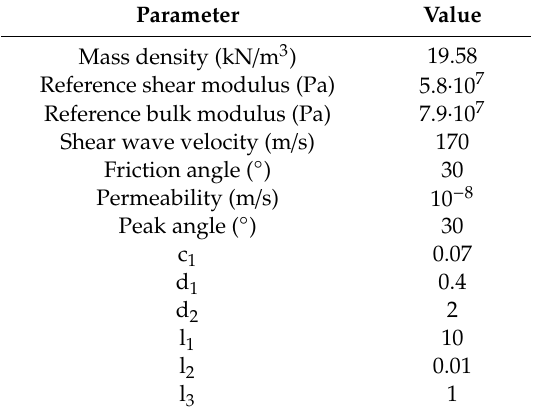
Table 3. PressureDependMultiYield02 (PDMY02) model parameters.